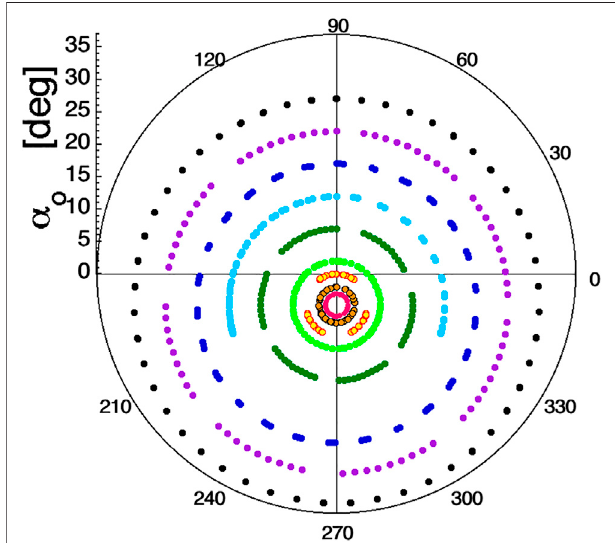
FIGURE 1 | For nine 700-keV protons launched at the geosynchronous orbit(L (cid:1) 6.6)equatorwithninedifferentinitialequatorialpitchangles,thepitch angle α o andgyrophaseangle ϕ o oftheprotonsatthetimesoftheirnorthward- going equatorial crossings isplotted. The magnetic- fi eld direction vector is at α o (cid:1) 0 o , where the black cross-hairs